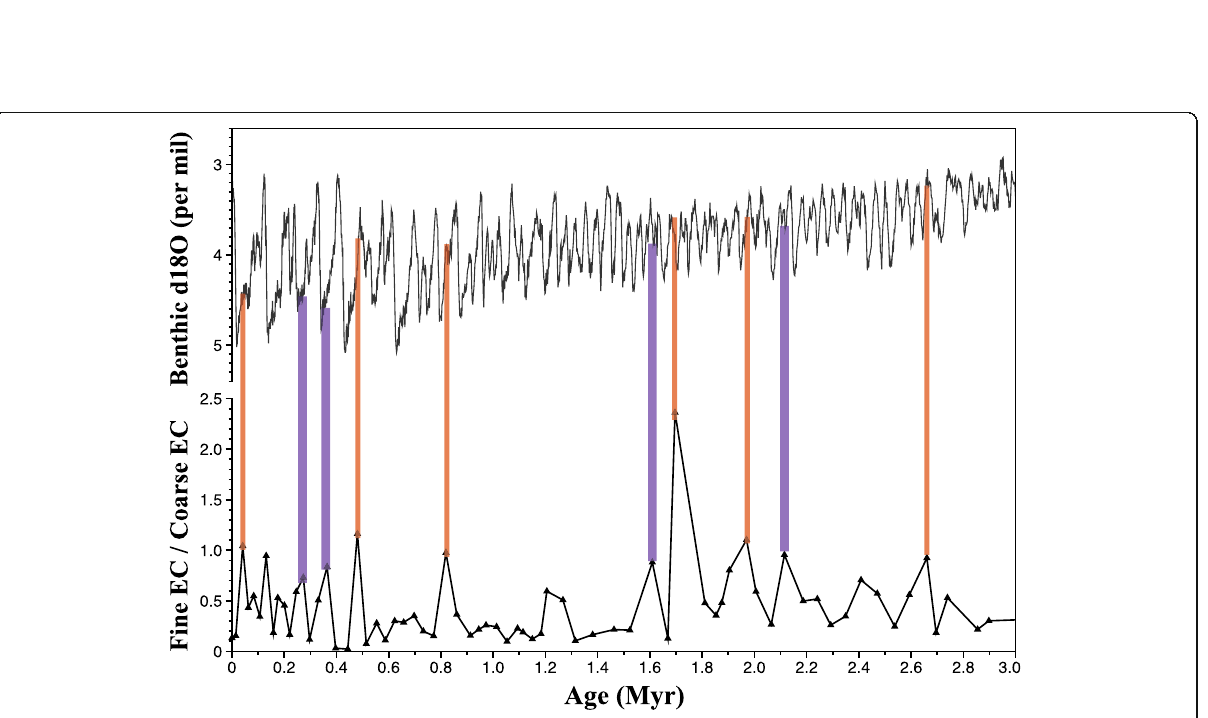
Fig. 8 Temporal variation of fine EC/course EC and LR04 standard benthic δ 18 O (Lisiecki and Raymo 2005. Significant maxima observed in temporal variations of fine EC/coarse EC are marked as blue and red vertical lines that correspond to glacial and interglacial stages,